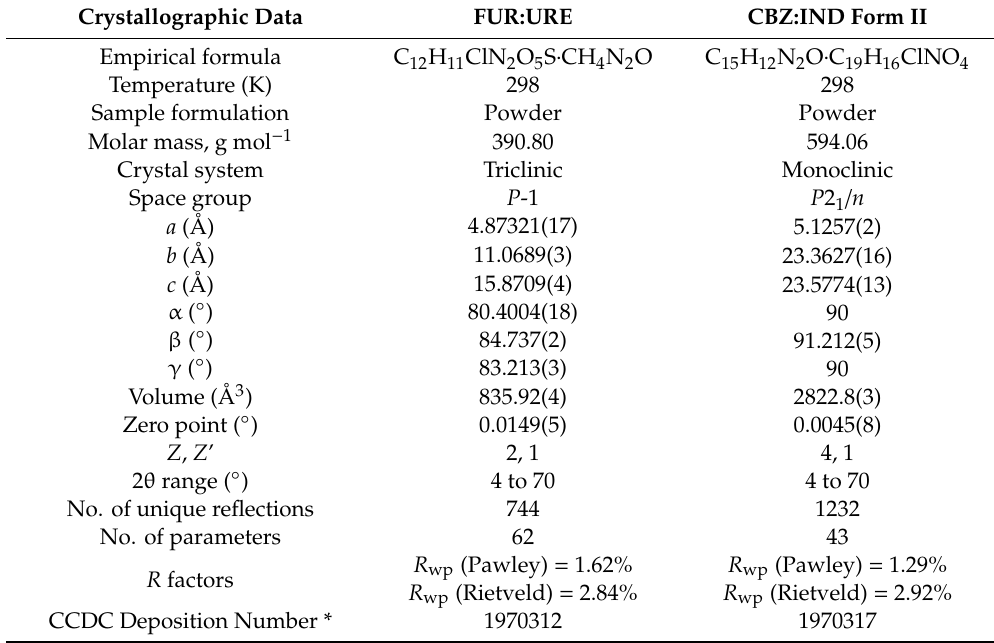
Table 3. Molecular structures and CSD REFCODES for the materials used in this